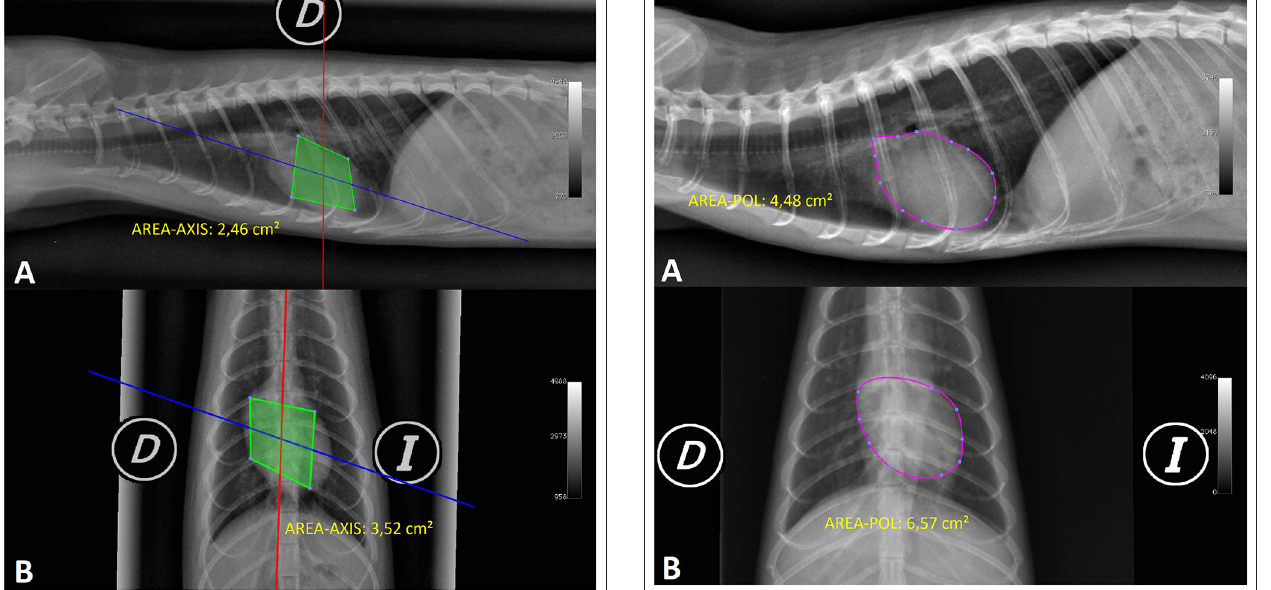
FIGURE 3 | Radiographic image in the right lateral (RL) and ventrodorsal (VD) projections of the normal thorax of a female ferret (A,B) . The X-rays show a measure of axis cardiac area (AREA-AXIS) in both projections (D, right; I, left).